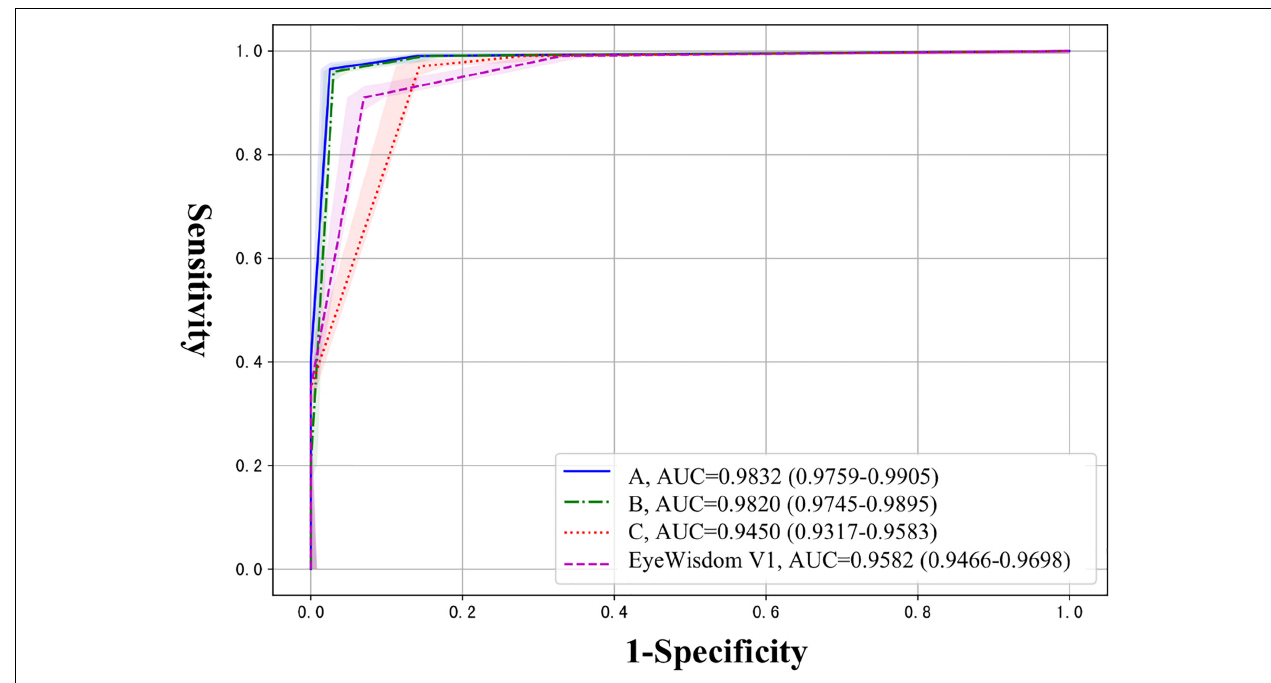
FIGURE 3 | The AUC of three graders and EyeWisdom V1 for referable DR.